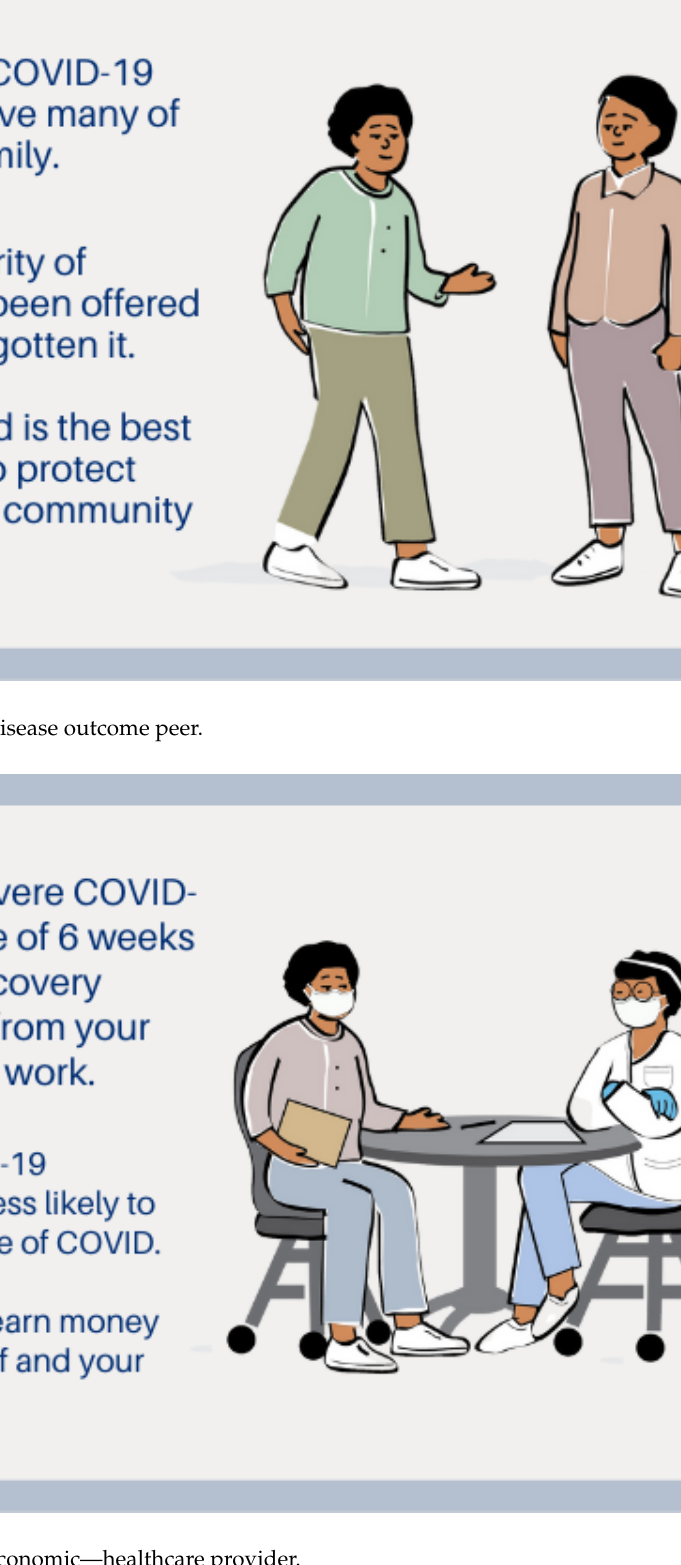
Figure A3. Economic—healthcare